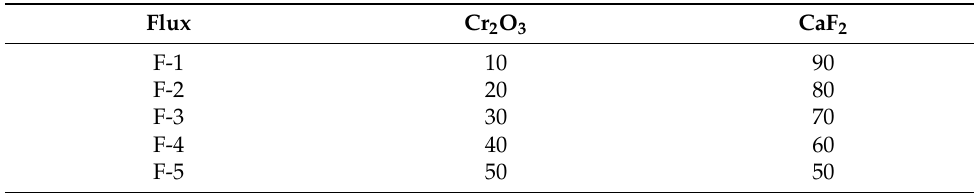
Table 1. Formulas of initial fluxes